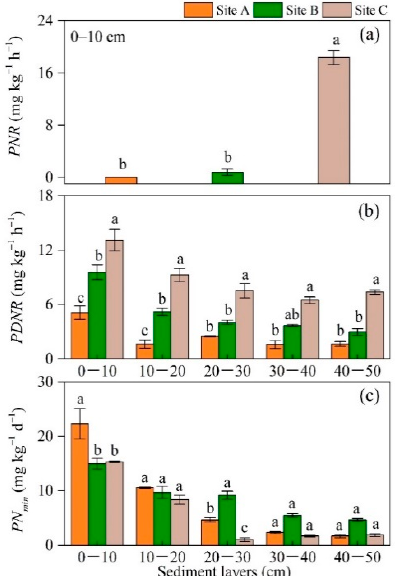
Figure 3. Measured ( a ) potential rates of nitrification ( PNR ), ( b ) potential rates of denitrification ( PDNR ), and ( c ) potential rates of mineralization ( PN min ) along the hydrological gradient (mean ± SE). Different letters above bars denote significant differences among sites ( p < 0.05). Sites A, B, and C refer to the high tidal flat, interaction zone between high and middle tidal flats, and middle tidal flat, respectively.